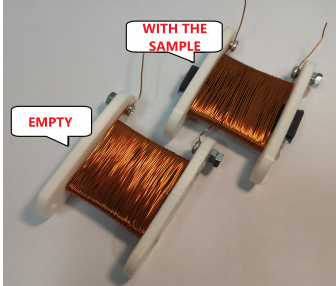
Figure 3. The example of coil built to perform estimate of relative